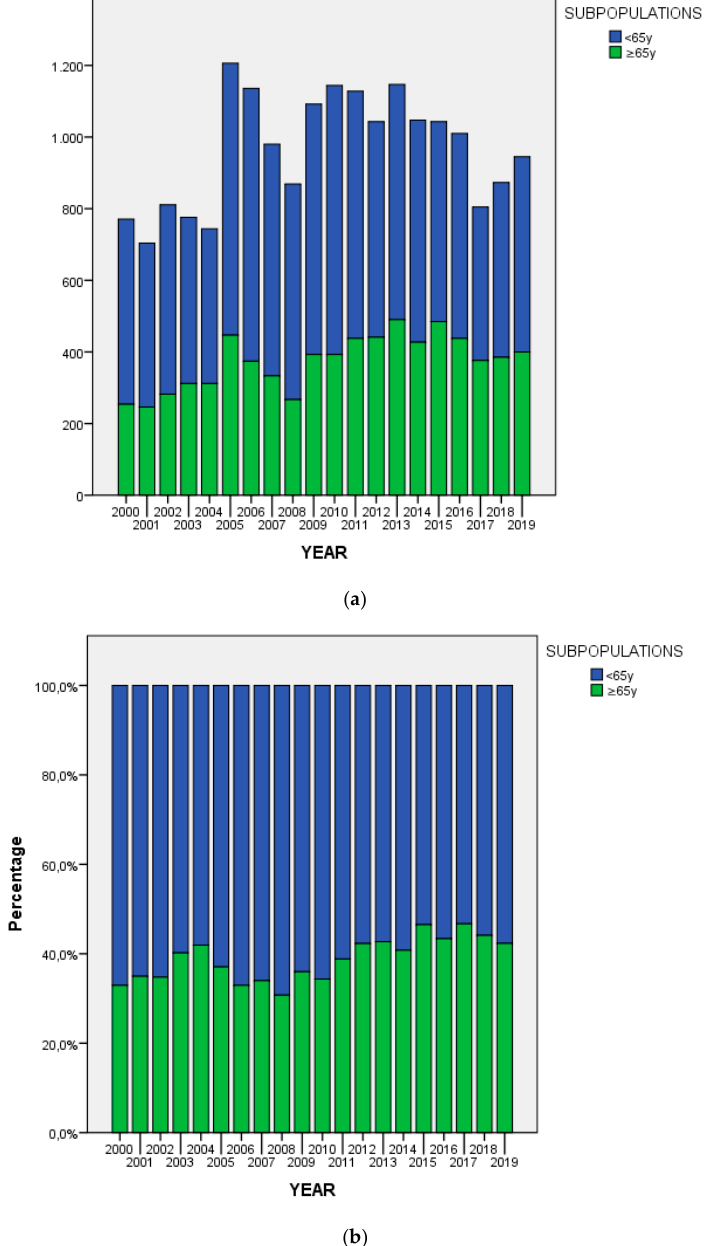
Figure 1. Consultations carried out from 2000 to 2019, divided into the two subpopulations. ( a ) Absolute value of psychiatric consultations carried out; ( b ) Percentage of psychiatric consultations carried out.